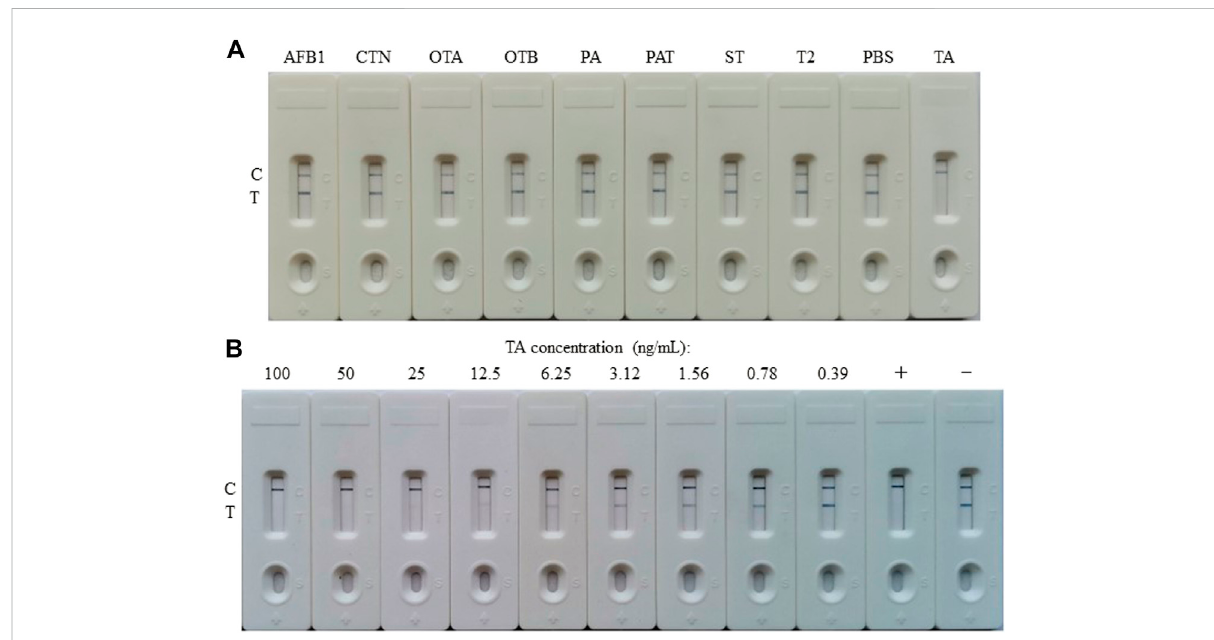
FIGURE 6 Characterization of the AuNF-based LFIA. (A) Cross-reactivity of AuNF-based strip test with other toxins, including a fl atoxin B1 (AFB1), citrinin (CTN), ochratoxin A (OTA), ochratoxin B (OTB), penicillic acid (PA), patulin (PAT), sterigmatocystin (ST), or trichothecenes-2 (T2), while PBS as negative. (B) The sensitivity of the AuNF-based strip test. +: positive, ‑ : negative.